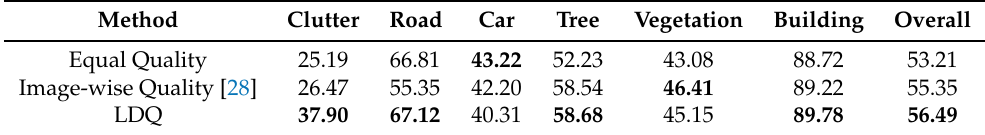
Table 4. The IoU (%) of each class with different methods of quality on POT → VAI. In LDQ, pseudo- labels’ threshold λ = 0.7, and K = 3. The results are averaged over three runs. Method